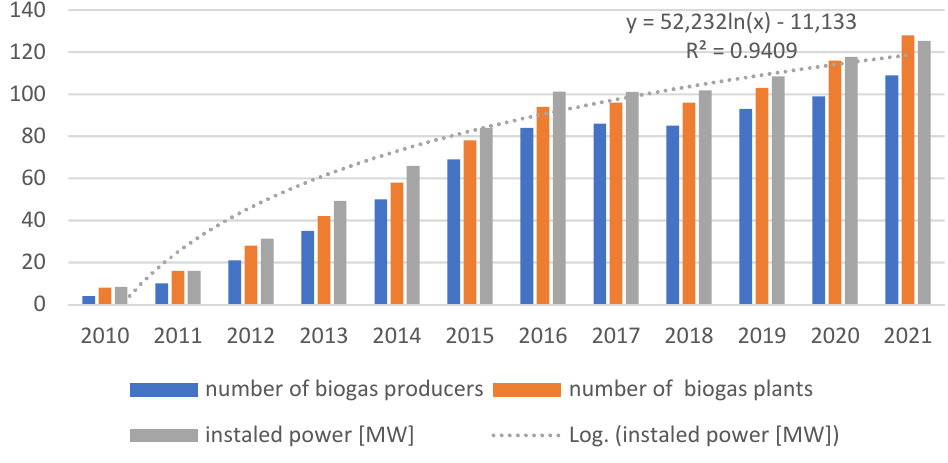
Figure 3. Number of agricultural biogas producers, biogas plants, and installed power. Source: [16].